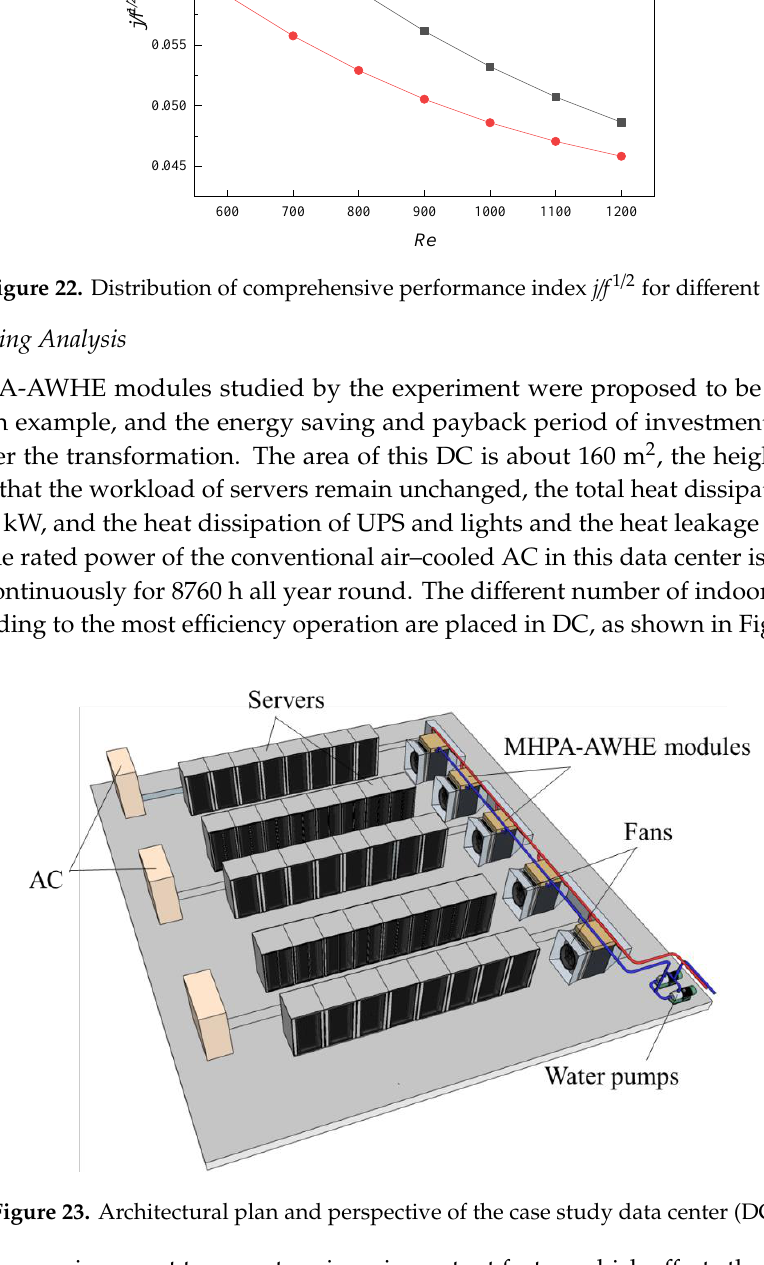
Environment temperature/ºCBeijing C oo li ng l o a d / k W Cooling load/kW Figure 24. Annual hourly outdoor environment temperatures and cooling load of Beijing. The fitting curve of EER 1 of conventional air-cooled AC that varies with environment temperature is obtained as Equation (13), and the annual power consumption of AC can be obtained before the transformation. The MHPA-AWHE module is proposed to use a natural cold source for the transformation of DC, however, with a different air flow rate, number of modules and outdoor environment, the performance of MHPA-AWHE module shows different heat transfer and pressure drop performances, and the electric power of fans and water pumps are also different. During the experiment, different water flow rates had little influence on the comprehensive performance, and the water flow rate and power consumption of pump remained unchanged. According to the annual hourly energy saving and equipment investment, the payback period of investment showed as